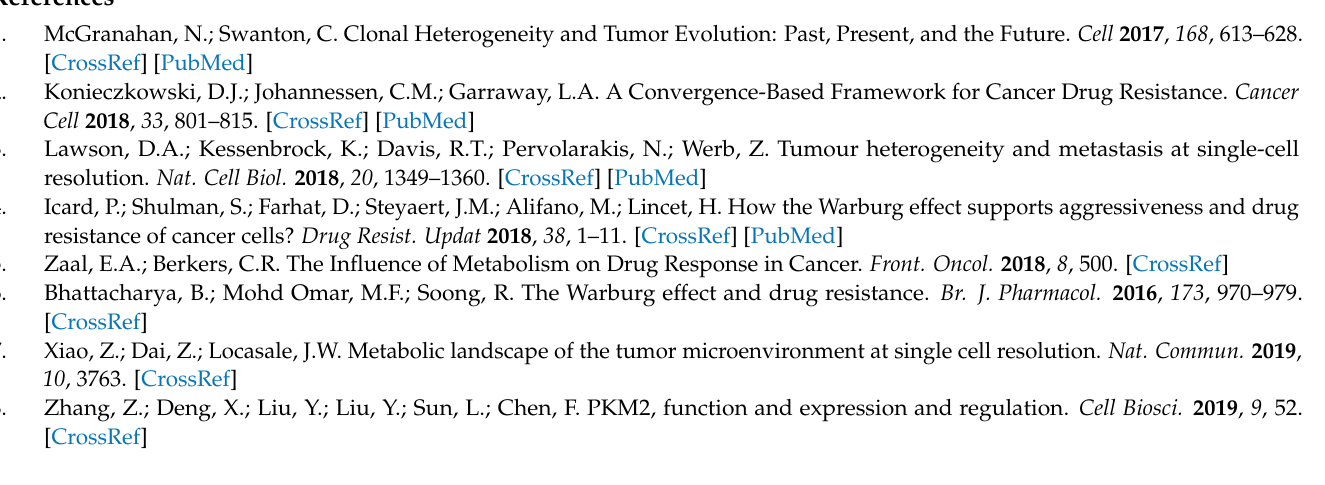
Figure S4: Fluorescence intensity distributions of PKM mRNA; Figure S5: Colocalization analysis of PKM1 and PKM2; Figure S6: Quantification of PKM isoforms by qRT-PCR measurements; Table